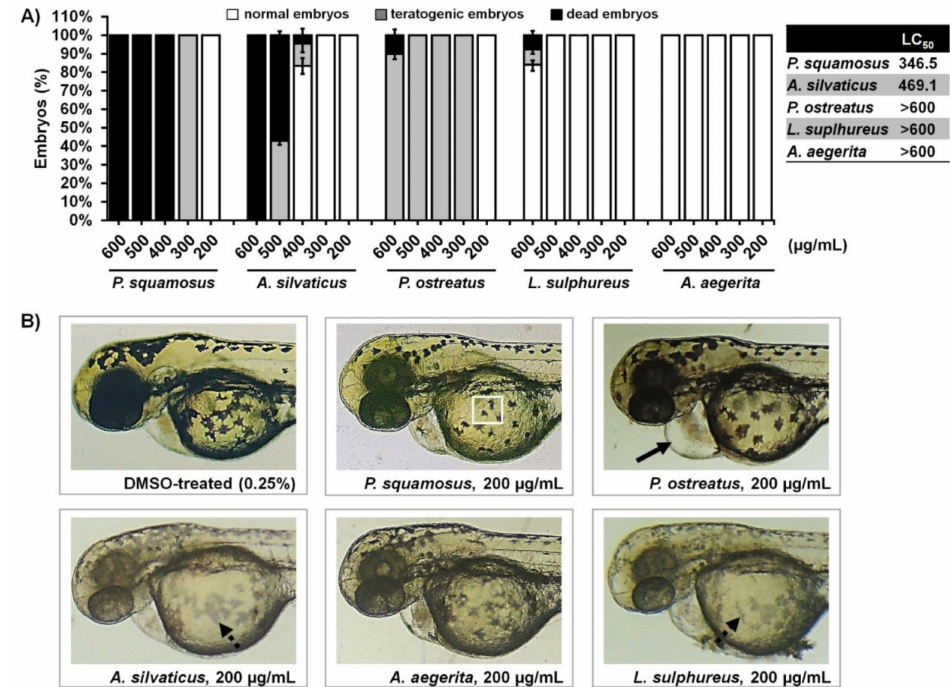
Figure 1. In vivo toxicity assessment of the ethanol extracts of five edible mushrooms in the zebrafish model, expressed as the lethal concentration (LC 50 ). Wild-type (AB) embryos were exposed to the different doses of each extract (n = 60 embryos per dose) in a period from 6 hpf to 120 hpf, and inspected for ( A ) the survival and signs of teratogenicity, including cardiotoxicity, hepatotoxic- ity, and teratogenicity. ( B ) Morphology of the zebrafish embryos at 72 hpf stage being exposed to 200 µ g/mL of each tested extracts is shown. At the applied dose, P. ostreatus caused a large pericardial edema (arrow), P. squamosus reduced size and morphology of the skin melanocytes (melanocyto- toxicity) without inhibitory effect on cells pigmentation (boxed), A. aegerita was non-toxic, while A. silvaticus and L. sulphureus prevented the melanocytes pigmentation (dashed arrow) without the melanocytotoxic